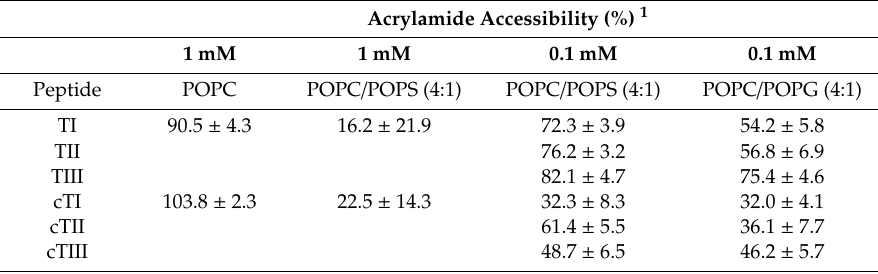
Table 8. Fluorescence quenching of 12.5 µ M tachyplesin I-III (TI-TIII) or cylic tachyplesin I-III (cTI-cTIII) by